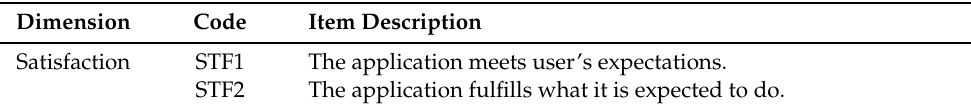
Table 13. The Satisfaction dimension and its items.